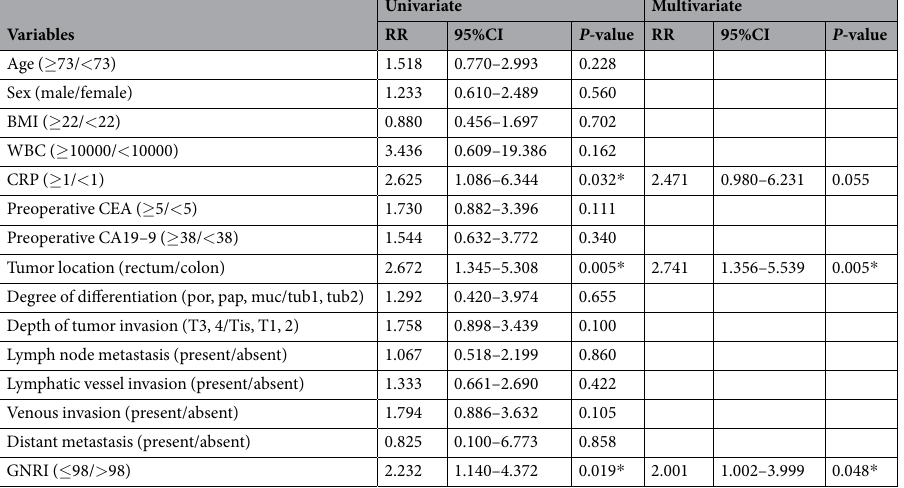
Table 4. The univariate and multivariate analyses of predictors for postoperative complications (CD grade ≥ II). CD = Clavien-Dindo, RR = risk ratio, CI = confidence interval, BMI = body mass index, WBC = white blood cell, CRP = C-reactive protein, CEA = carcinoembryonic antigen, CA19–9 = carbohydrate antigen 19-9, por = poorly differentiated adenocarcinoma, pap = papillary adenocarcinoma, muc = mucinous adenocarcinoma, tub1 = well differentiated adenocarcinoma, tub2 = moderately differentiated adenocarcinoma, GNRI = geriatric nutritional risk index, Asterisk values indicate P-values <